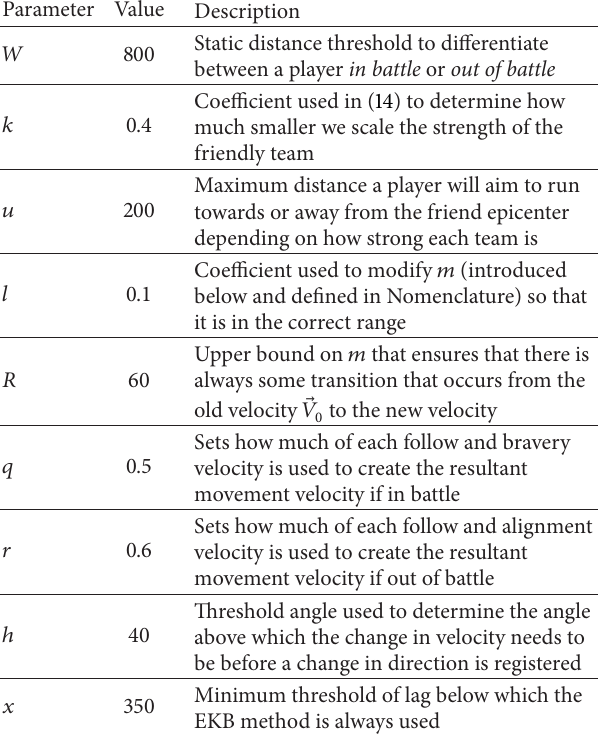
Table 1: Parameter space.